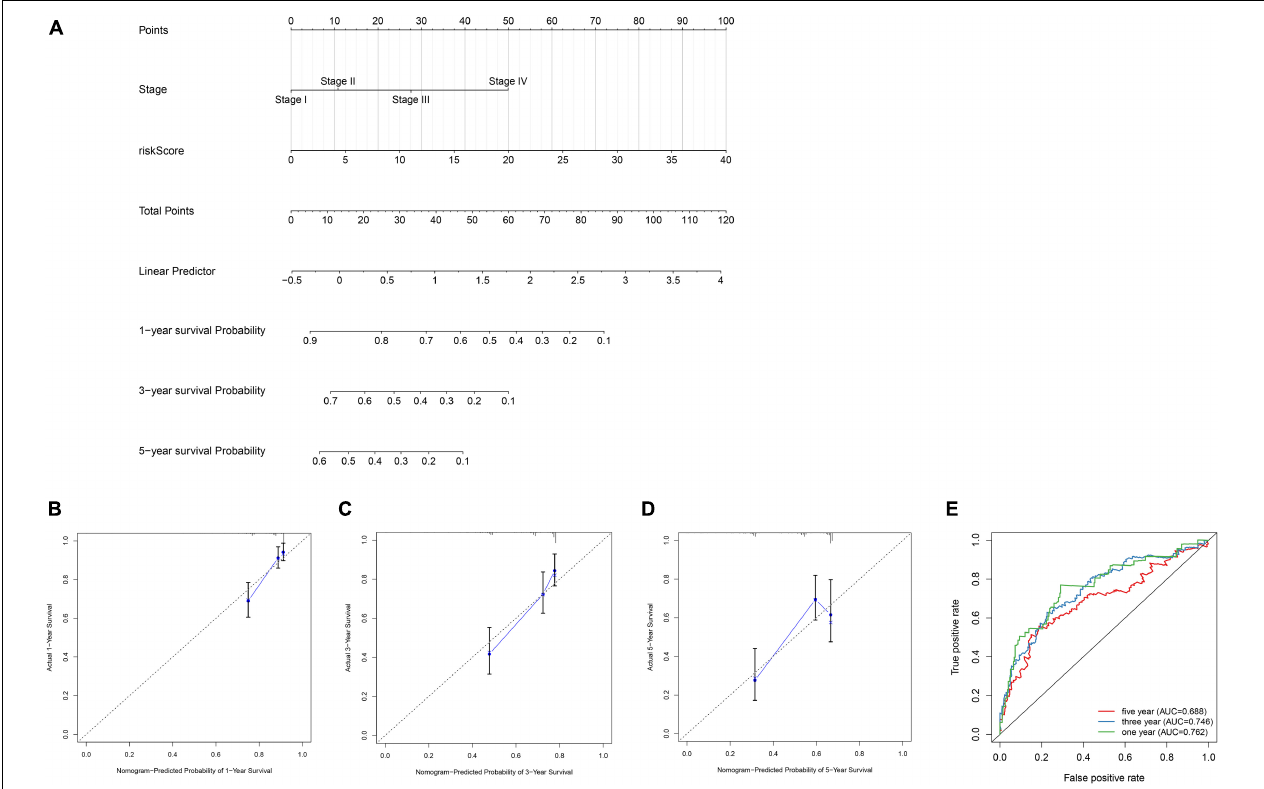
FIGURE 7 | Construction of the nomogram and calibration curve plot. (A) Nomogram construction based on the independent clinical factors including stage and risk score. (B) Calibration curve plot for predicting 1-year OS in TCGA dataset. (C) calibration curve plot for predicting 3-year OS in TCGA dataset. (D) Calibration curve plot for predicting 5-year OS in TCGA dataset. (E) ROC curves analysis of the nomogram in 1-, 3-, and 5-year